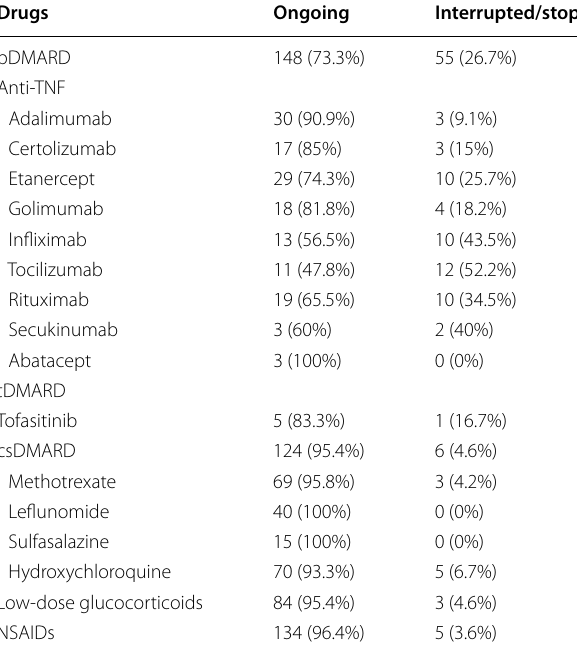
Table 2 Distribution of ongoing and Interrupted/stop